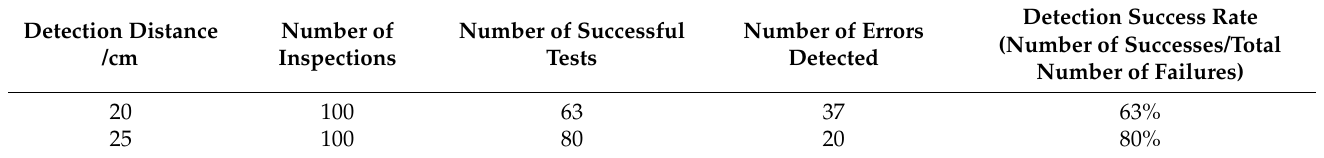
Table 5. Experimental data of short distance road sign recognition.